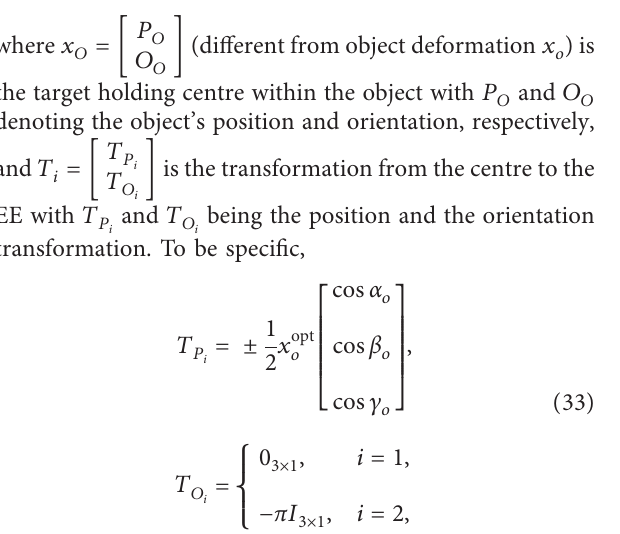
Figure 4: A symmetric way to hold the object by two robots, where two EEs approach the object centre